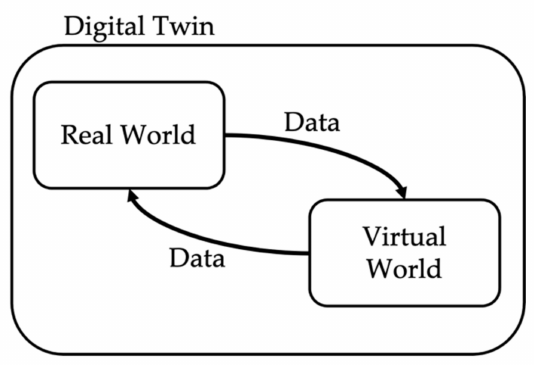
Figure 1. Schematic representation of the DT